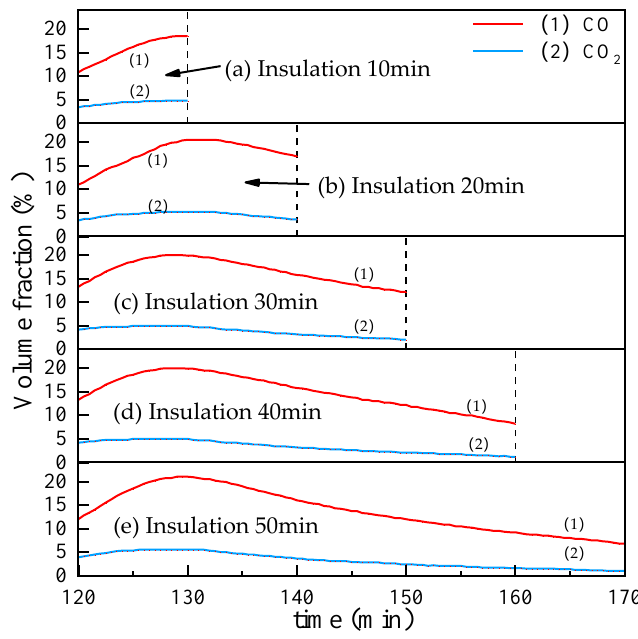
Figure 12. The influence of insulation time on the CO and CO 2 contents in the off-gas.